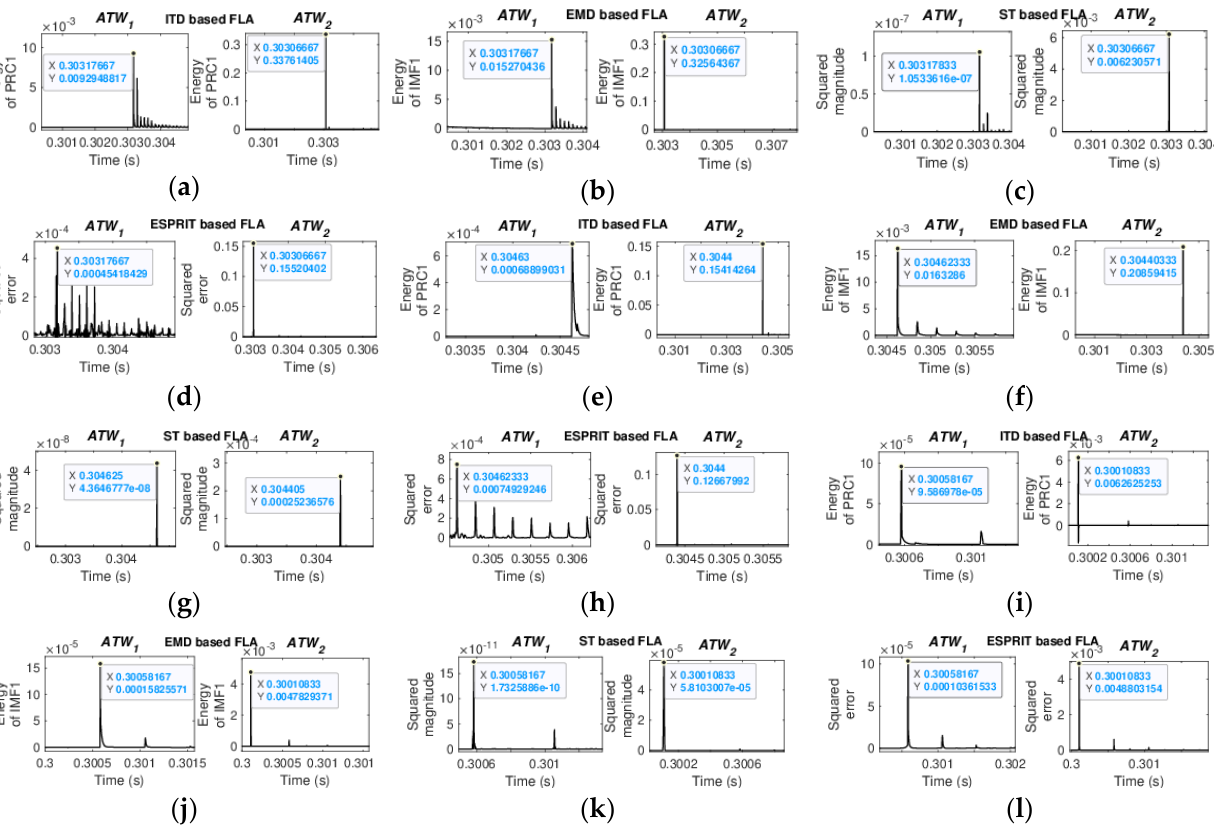
Figure 7. Estimation of ATWs for shunt-compensated systems for faults after STATCOM. ( a – d ) Es-